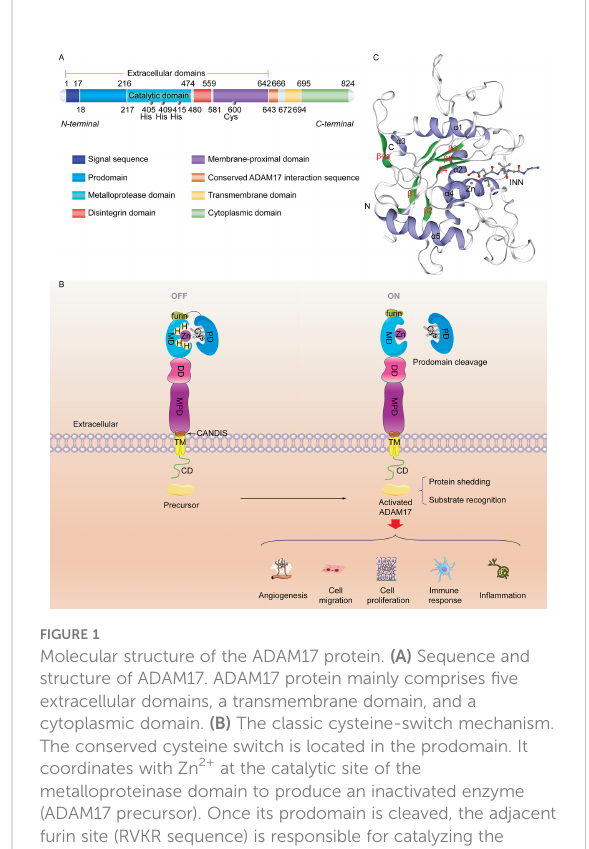
FIGURE 1 Molecular structure of the ADAM17 protein. (A) Sequence and structure of ADAM17. ADAM17 protein mainly comprises fi ve extracellular domains, a transmembrane domain, and a cytoplasmic domain. (B) The classic cysteine-switch mechanism. The conserved cysteine switch is located in the prodomain. It coordinates with Zn 2+ at the catalytic site of the metalloproteinase domain to produce an inactivated enzyme (ADAM17 precursor). Once its prodomain is cleaved, the adjacent furin site (RVKR sequence) is responsible for catalyzing the separation of zinc from cysteine, ultimately leading to ADAM17 activation. (C) The 3D catalytic structure of ADAM17 (PDB